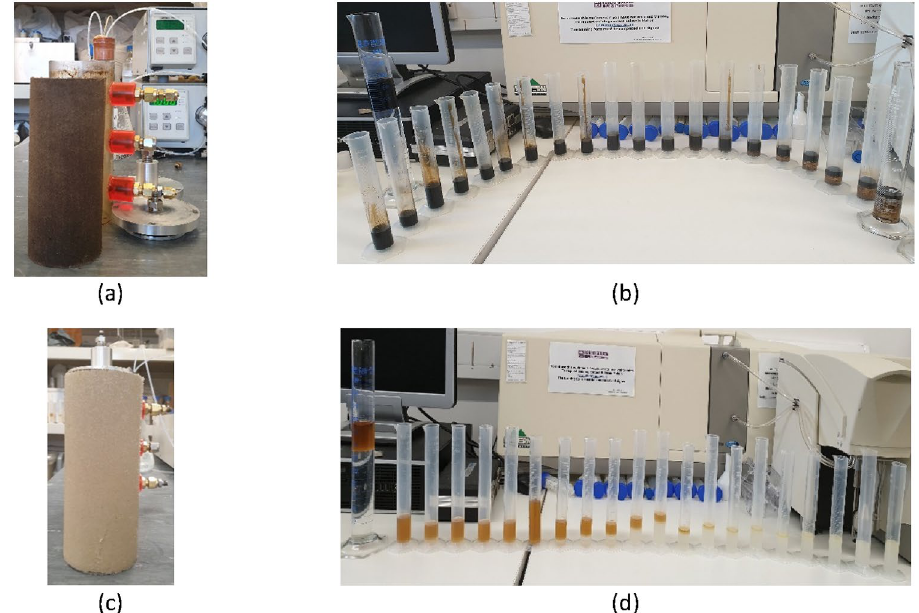
Fig. 8 Sandpack and produc- tion effluent samples for differ-